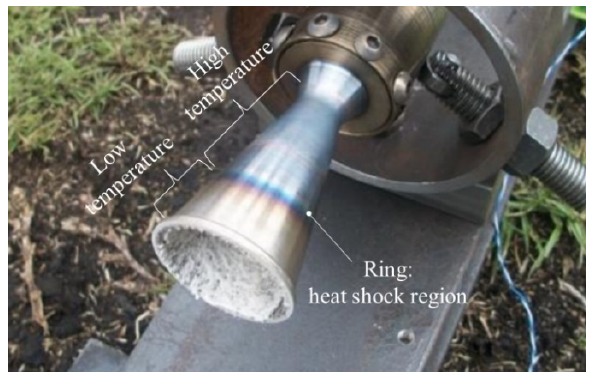
Figure 1. The conical nozzle was subjected to experimental static testing by Riveros and Rodriguez